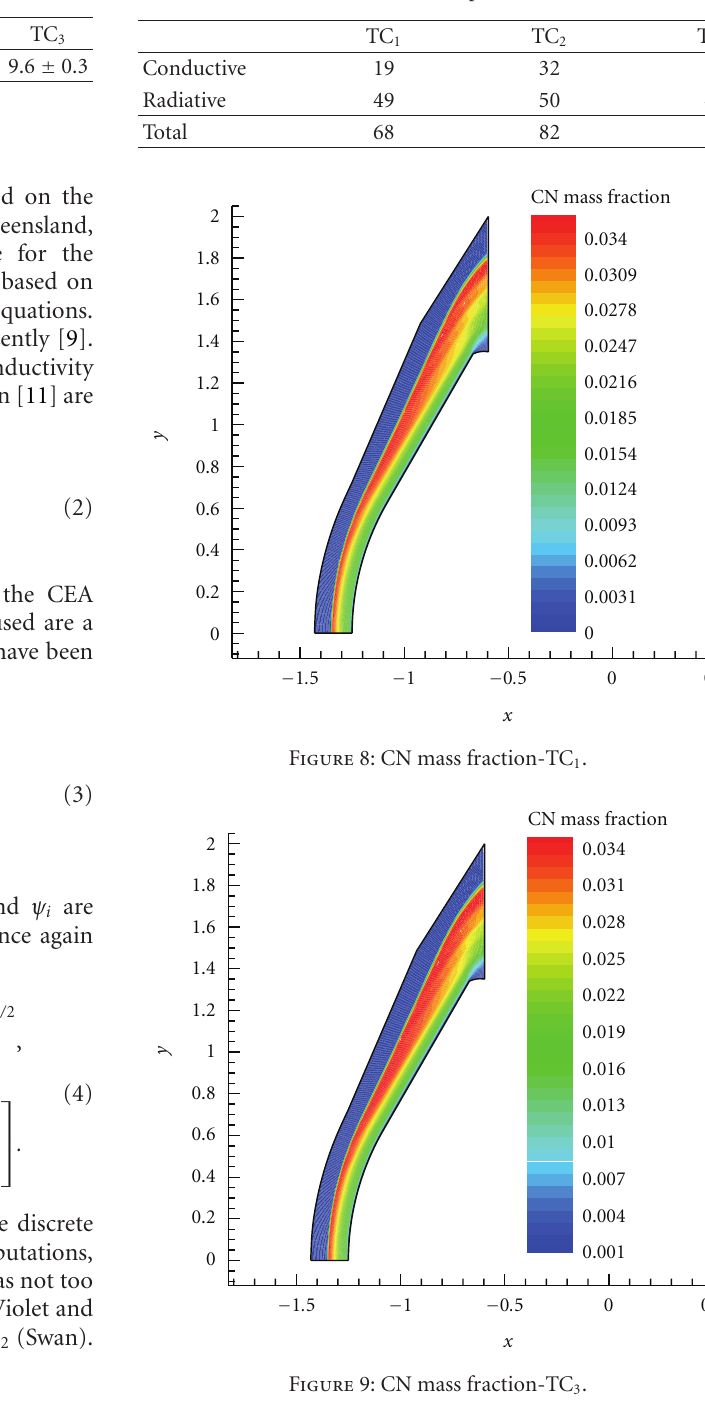
Table 1: Shock stando ff distance (cm). Table 2: Heat fluxes comparison (W/cm 2 ).